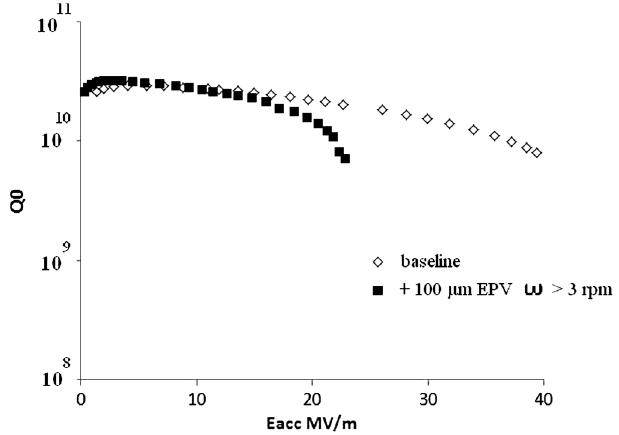
FIG. 4. Deterioration of C1-21 single-cell cavity after horizon- tal EP at rotation speed ! > 3 rpm